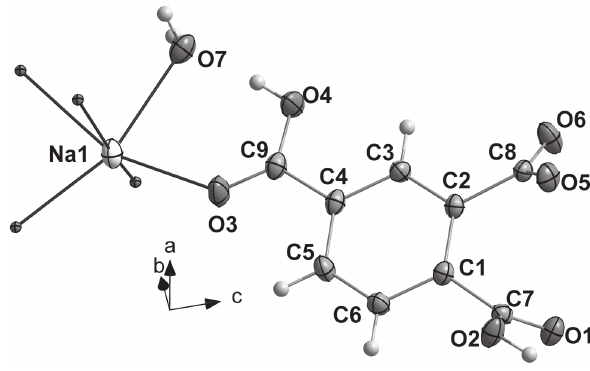
Table 2: Fractional atomic coordinates and isotropic or equivalent isotropic displacement parameters (Å 2